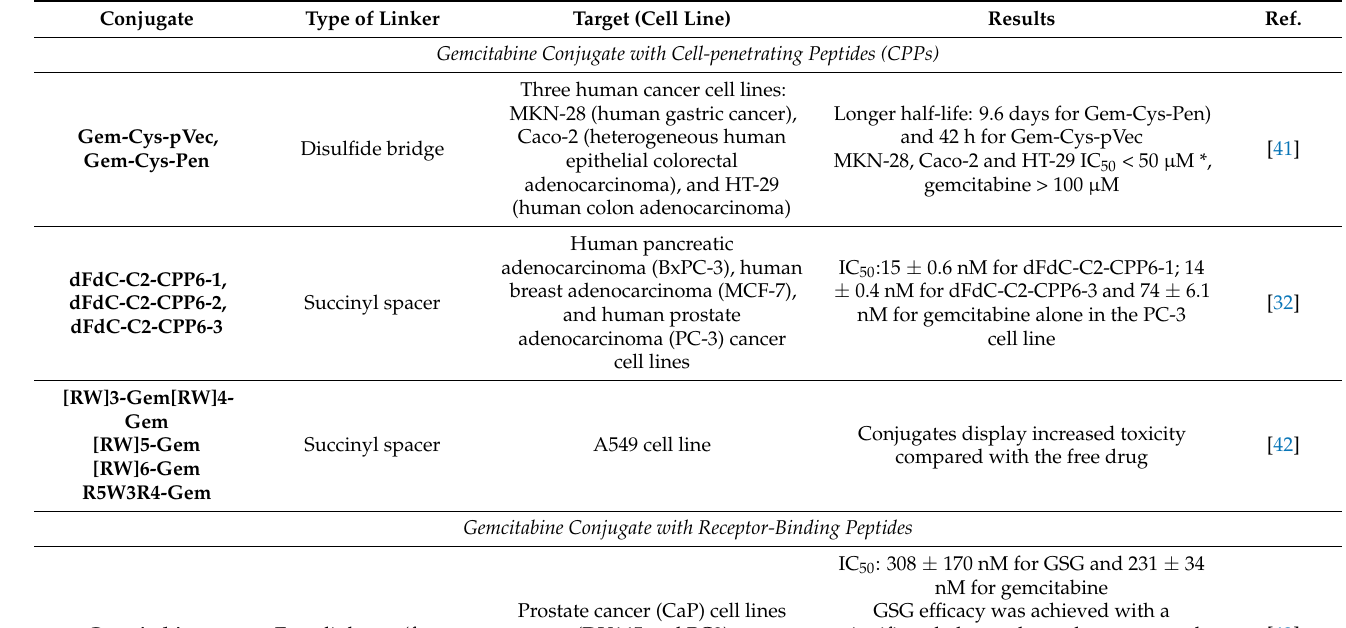
Table 1. Gemcitabine-peptide conjugates designed for the anticancer